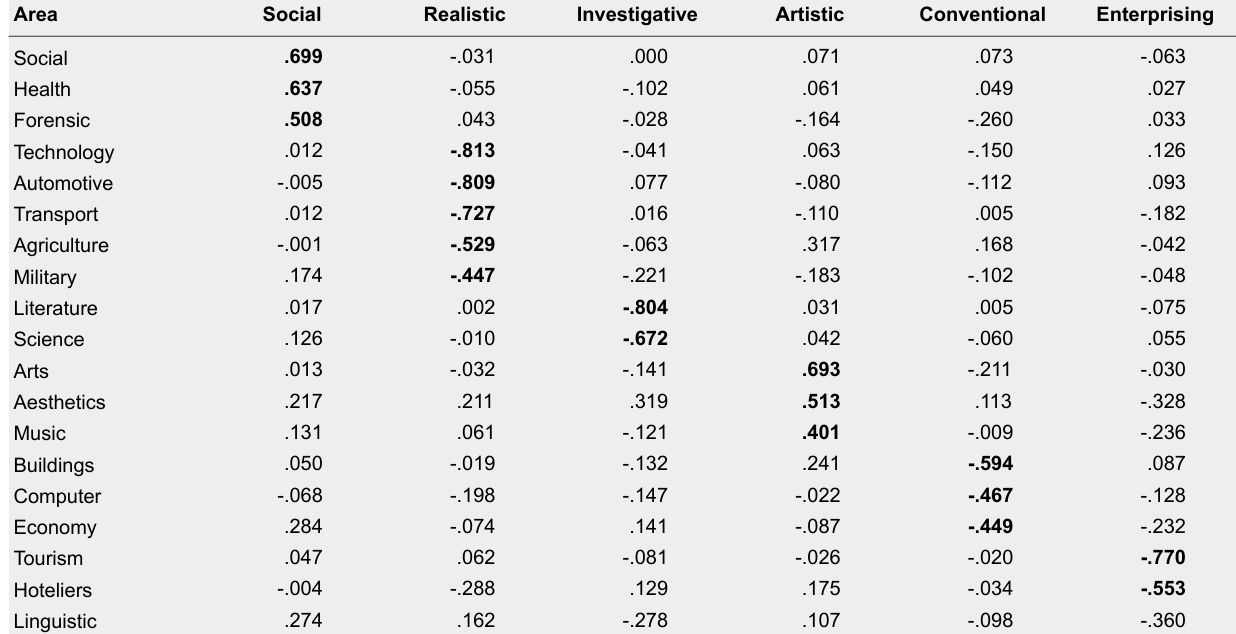
Model Matrix of Explorative Factorial